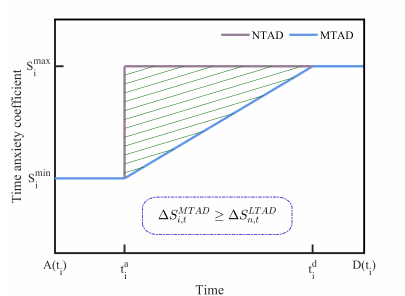
Figure 4. The time anxiety impact of MTAD.